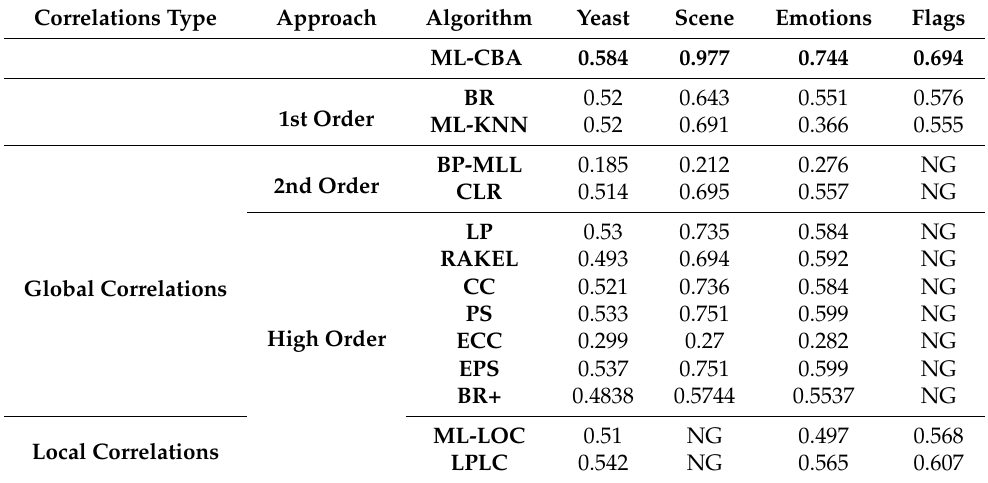
Table 2. Evaluation of the proposed ML-CBA algorithm on the regular-sized datasets using accuracy metric, with respect to different MLC algorithms.